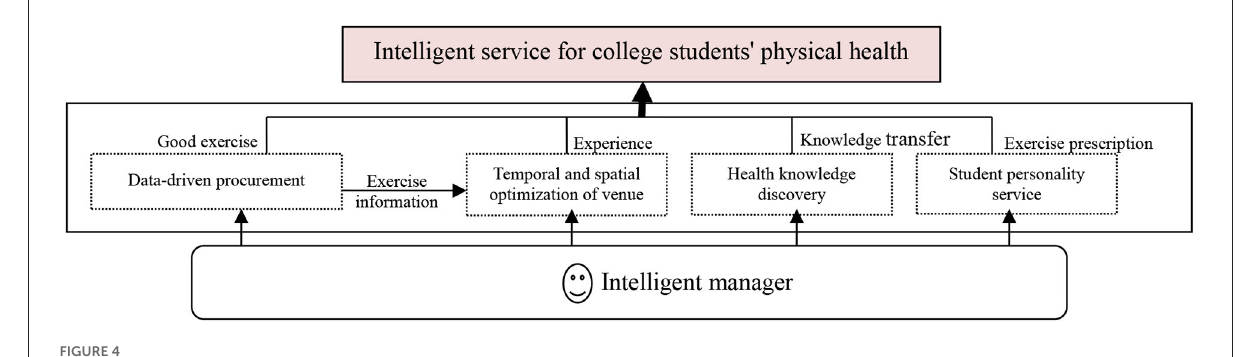
FIGURE4 Service application